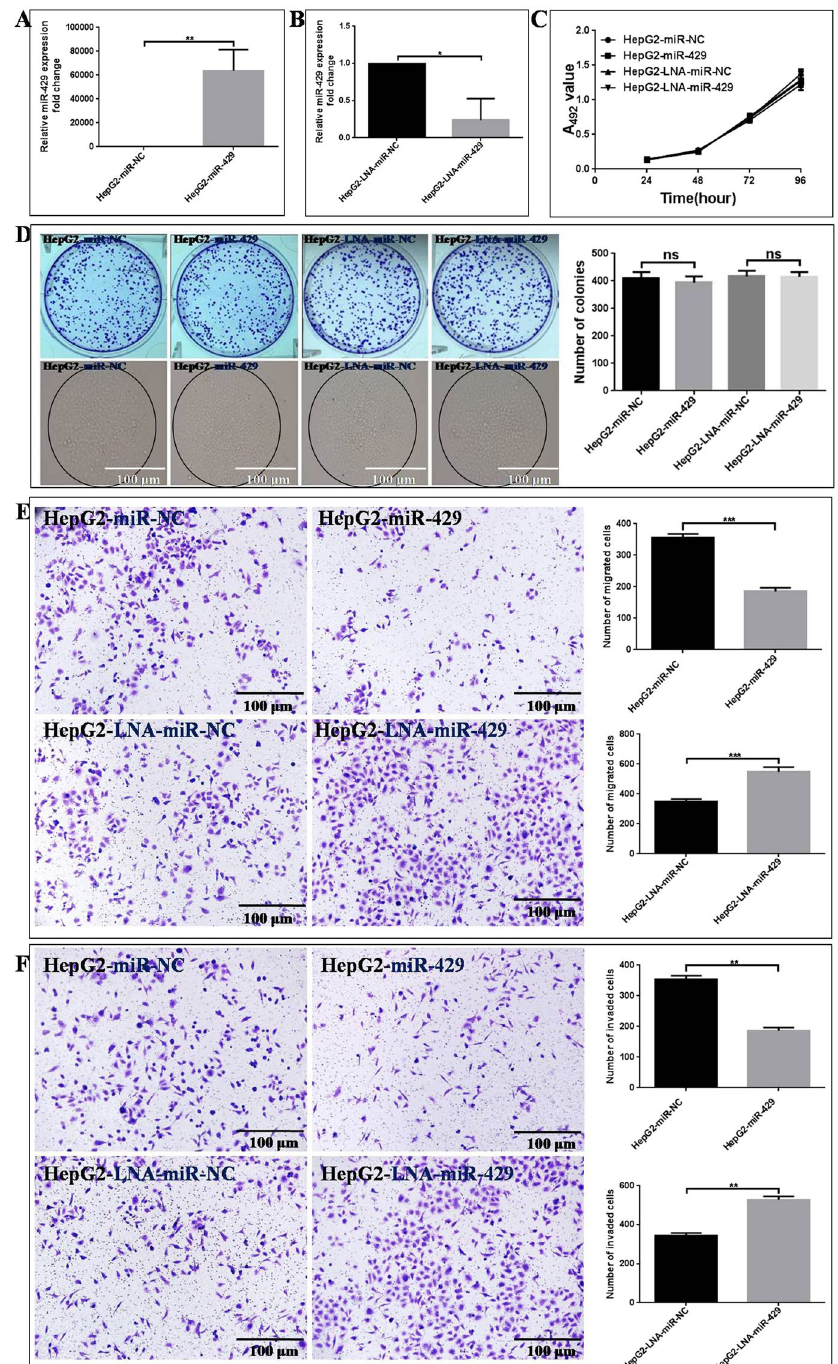
Figure 3. The influence of miR-429 level on the in vitro proliferation, colony forming, migration and invasion abilities of HepG2. ( A ) miR-429 was over-expressed in HepG2. miR-429 mimic or miR-NC were transiently transfected into HepG2 cells for 48 h, the miR-429 expression level was determined by qRT-PCR using U6 as internal reference. ( B ) miR-429 was downregulated in HepG2 cells. LNA-miR-429 or LNA-miR-NC were transiently transfected into HepG2 cells for 48 h. miR-429 level was determined by qRT-PCR using U6 as internal reference. ( C ) miR-429 level change shows no influence on HepG2 proliferation by MTT assay. ( D ) miR-429 level change exhibits no influence on HepG2 colony forming ability by clonogenic assay. ( E , F ) The effects of miR-429 level change on the migration and invasion capacities of HepG2 cells by Boyden transwell- chamber assay. For all the experimental results, the differences marked with *** and *** were with the P values below 0.05, 0.01 and 0.001 in comparison with the negative control, and ns refers to non stastical